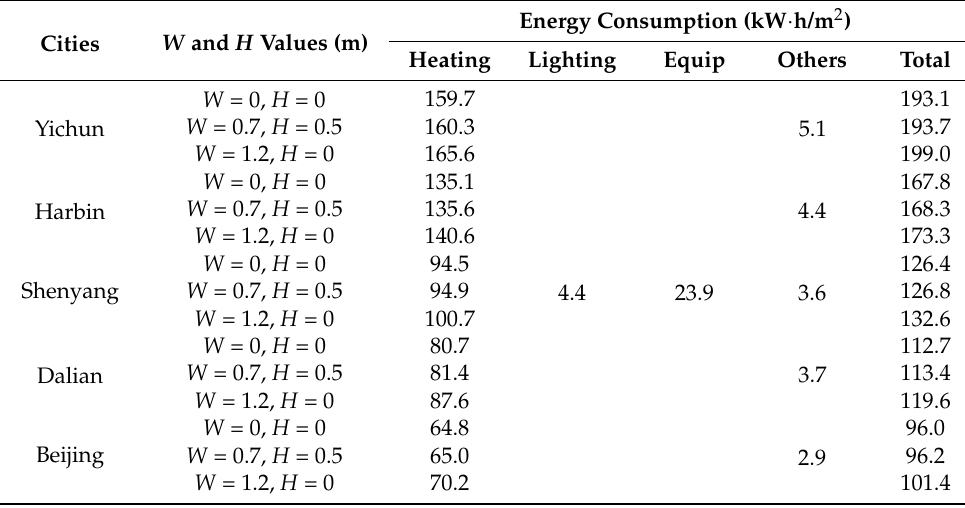
Table 14. Building energy consumption composition in five cities.